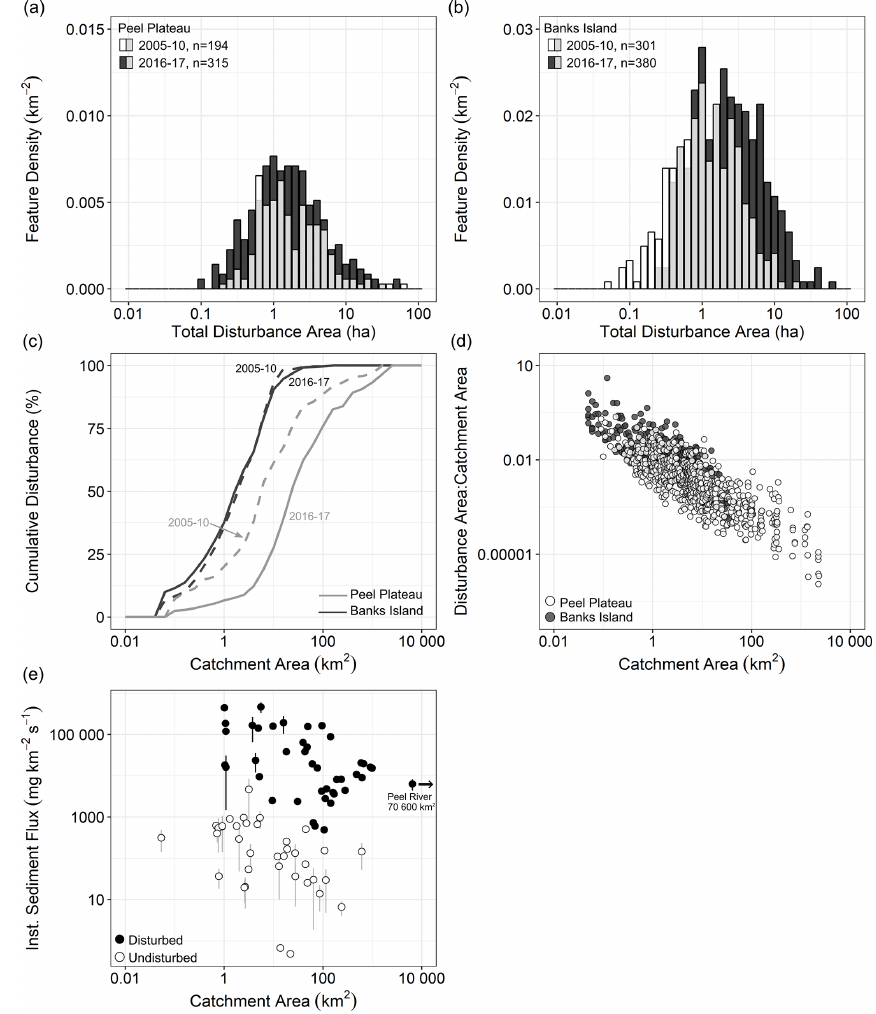
Figure 7. The patterns of retrogressive thaw slump intensification in fluvial networks for 2005–2010 and 2016/17 in the Peel Plateau (3520km 2 ) and eastern Banks Island (1220km 2 ) regions. (a, b) Size distribution of thaw slumps for the two time periods; white indi- cates 2005–2010, black indicates 2016/17, and shading shows overlap between 2005–2010 and 2016/17 distributions. (c) Cumulative count of thaw slumps plotted against upstream catchment area. (d) The ratio of disturbance area to upstream catchment area plotted against up- stream catchment area. (e) July–September instantaneous total suspended solid flux rates for streams of the Peel watershed and adjacent